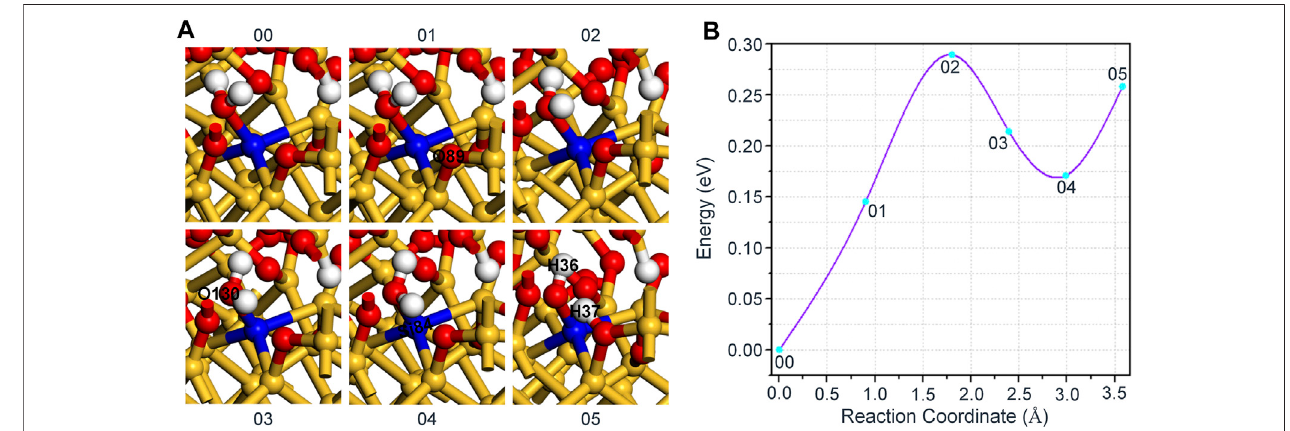
FIGURE 5 | (A) The schematic diagram of the reaction between P b1 defect and H 2 O. (B) The variation of the energy with different reaction coordinates for the reaction of H 2 O and P b1 defect with AOD con fi guration at random position 1.